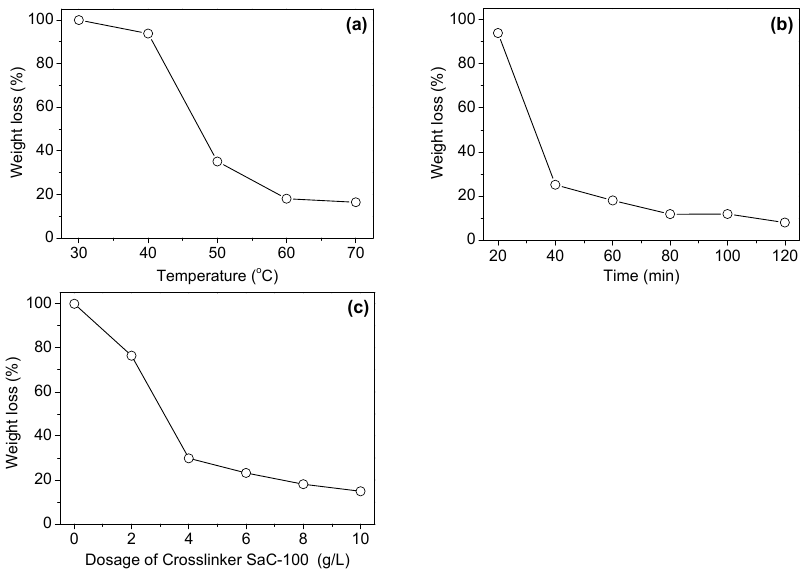
Figure 2. Effects of temperature ( a ), time ( b ) and Crosslinker SaC-100 dosage ( c ) used in crosslinking treatment on the weight loss of the crosslinked chitosan fiber in acidic solution.